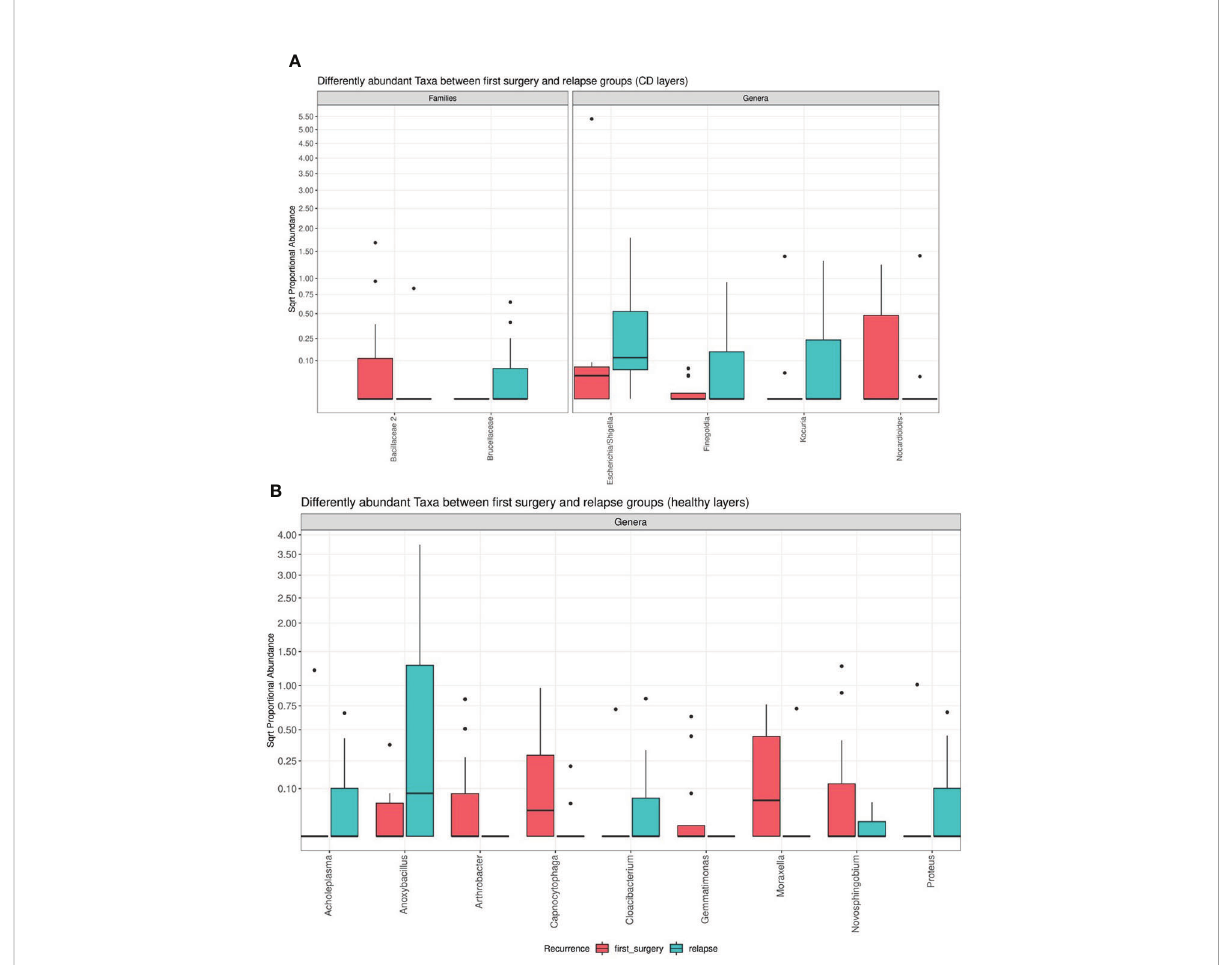
FIGURE 6 Box plot showing the results of taxa differential abundance analysis between the fi rst surgery and relapse patients, respectively, in CD (A) and healthy tissues (B) . The y – axis has been scaled to improve the readability of values. All results have an adjusted p – value